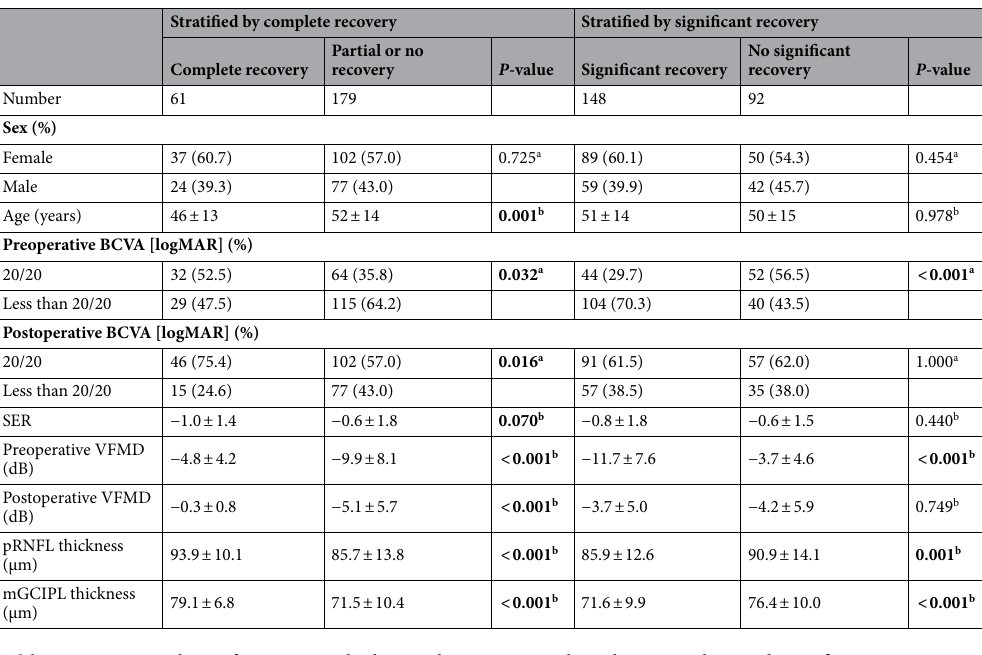
Table 1. Demographics of patients with chiasmal compression based on complete and significant recovery. BCVA best-corrected visual acuity, SER spherical equivalent refractive errors, VFMD visual field mean